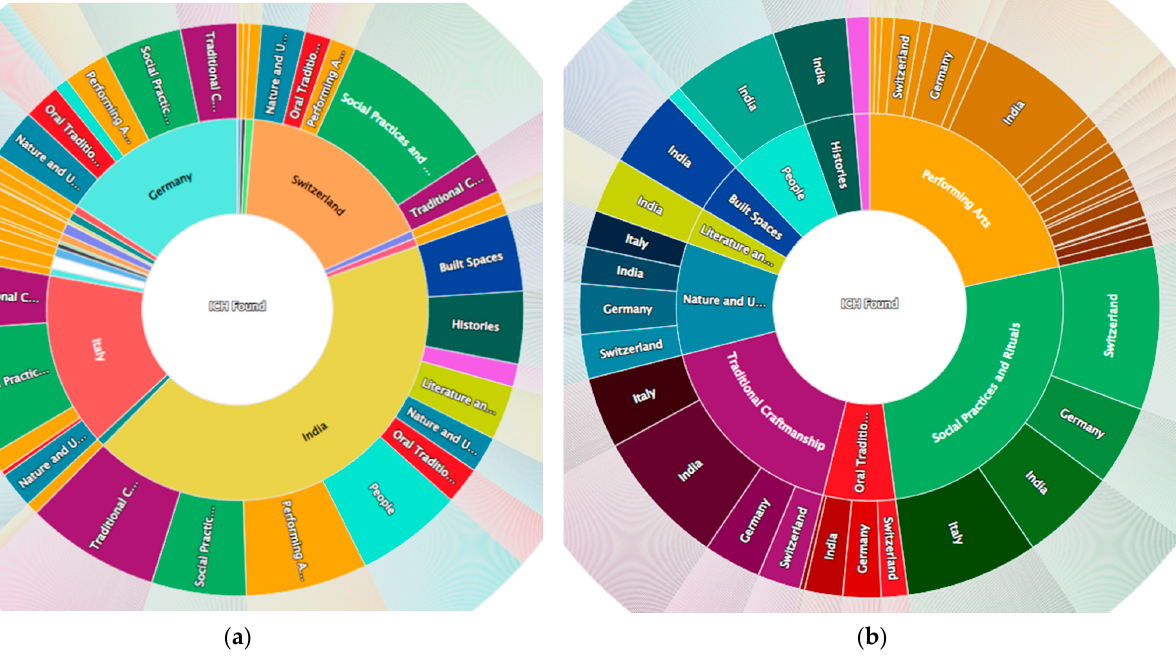
Figure 11. All ICH items displayed by sunburst: ( a ) the main key for the inner circle is the country; ( b ) the main key is the domain.